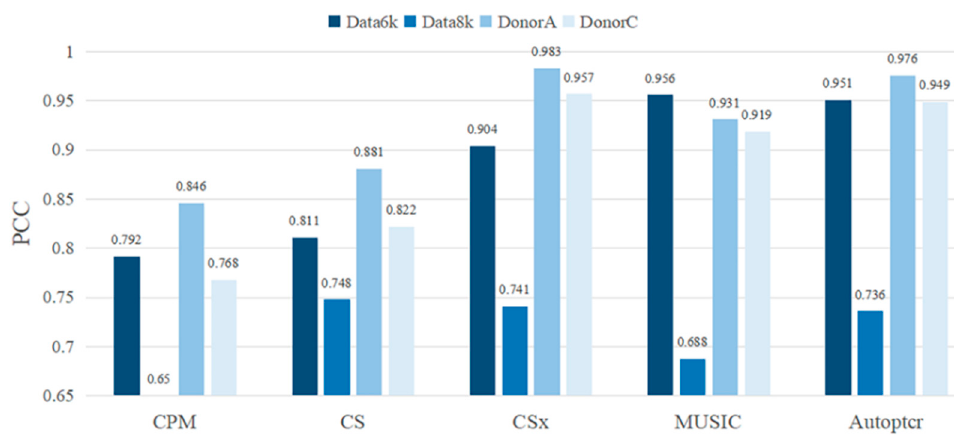
Figure 3. PCC of CPM, CS, CSx, MusiC, and Autoptcr on four datasets.